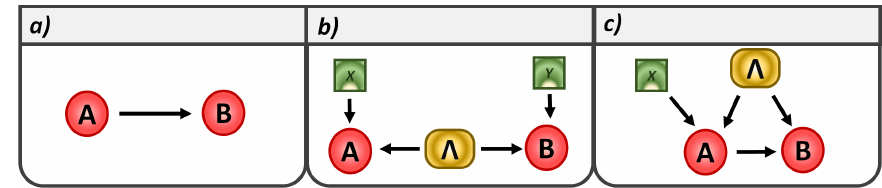
Figure 1. Directed Acyclic Graphs representing causal models. In this figure, we show three different causal models represented by Directed Acyclic Graphs (DAG) [2], where each node represents a variable and the arrows link variables between whom there is a causal relationship. ( a ) This is the simplest causal model in which a variable A has an influence over B, but it has no testable mathematical constraints characterizing the allowed joint probabilities p ( a , b ) . ( b ) The causal model of a CHSH scenario, where the parties Alice (A) and Bob (B) share a system and choose the basis on which to measure it according two independent variables, X and Y. Hence, no communication must occur between A and B. ( c ) DAG representing the instrumental scenario, whose main difference from the CHSH Bell-like scenario, is the presence of a classical channel of communication between the parties, i.e., A has a causal influence over